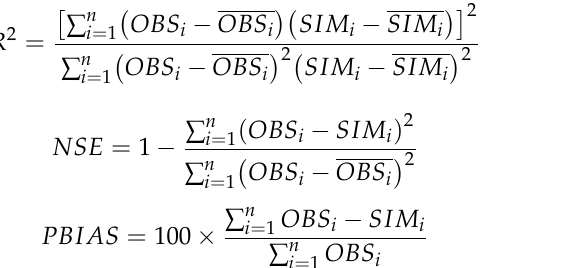
Figure 3. The distribution of land-use types in the study area. ( a ): 2000, ( b ): 2016.